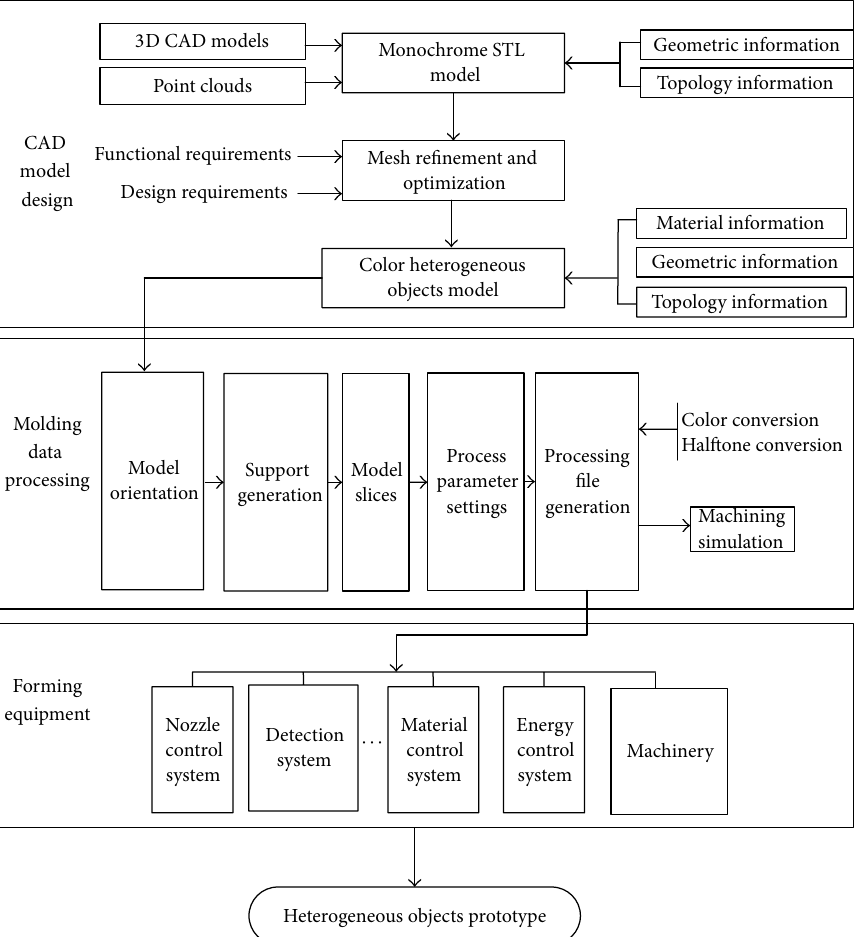
Figure 1: Molding process of HEO prototype system.